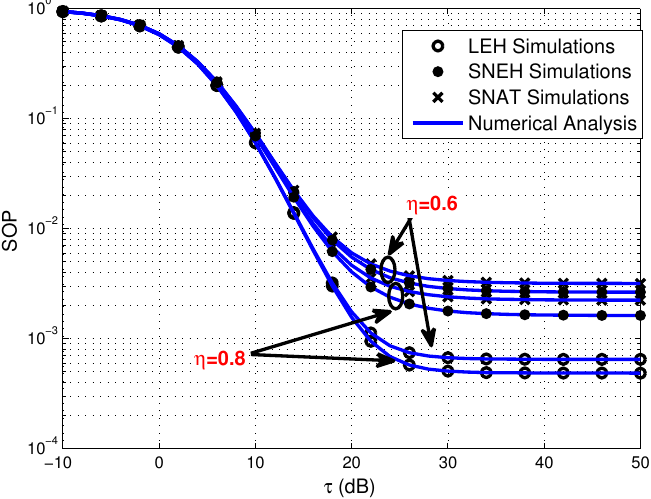
Figure 4. Secrecy outage probability versus τ for three EH modes under various η , where η = { 0.6,0.8 }